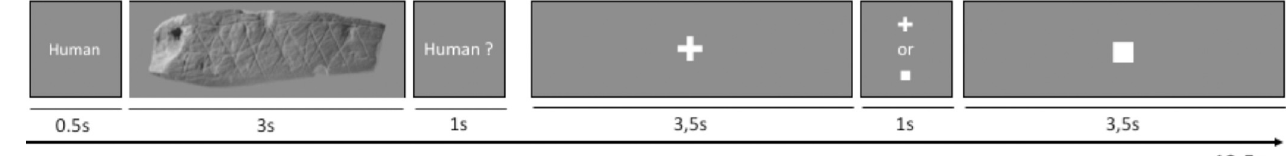
Fig 1. Organization of a trial in the judgment task. Participants were presented each item twice (once during the Attribution and once during the Orientation task). The participants were shown 21 different human-made and 21 natural marks.